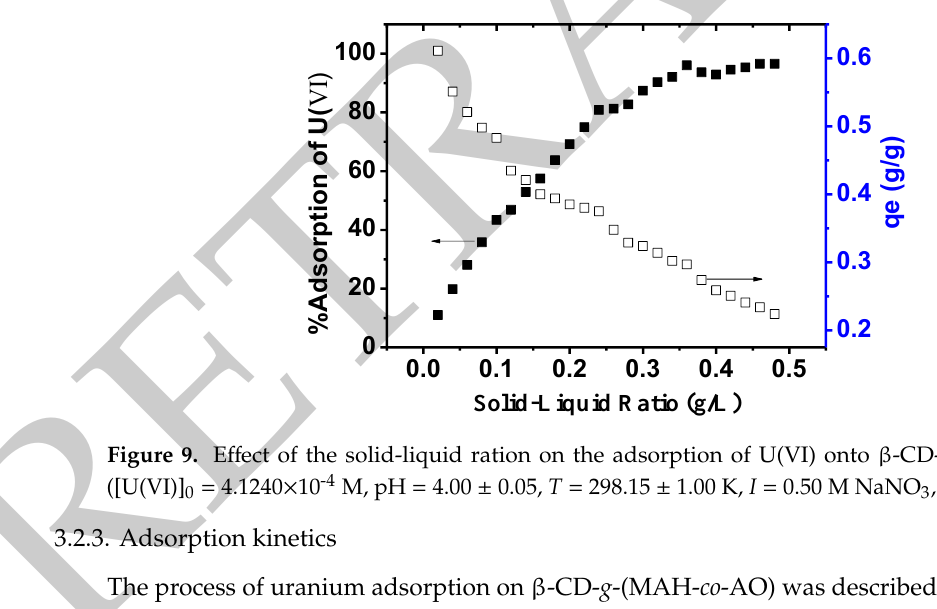
Figure 9. E ff ect of the solid-liquid ration on the adsorption of U(VI) onto β -CD- g -(MAH- co -AO). Figure 9. Effect of the solid-liquid ration on the adsorption of U(VI ) onto β -CD- g -(MAH- co -AO). ([U(VI)] 0 = 4.1240 × 10 -4 M, pH = 4.00 ± 0.05, T = 298.15 ± 1.00 K, I = 0.50 M NaNO 3 , t = 4 ([U(VI)] 0 = 4.1240×10 -4 M, pH = 4.00 ± 0.05, T = 298.15 ± 1.00 K, I = 0.50 M NaNO 3 , t = 4 h).